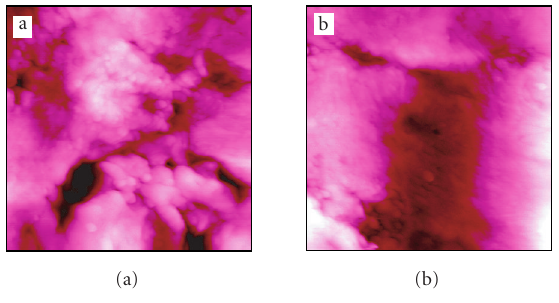
Figure 27: Shear-force AFM (10 μ m, Z range 1 μ m) of unstained microtome cuts of (a) cancerous bladder tissue and (b) healthy bladder